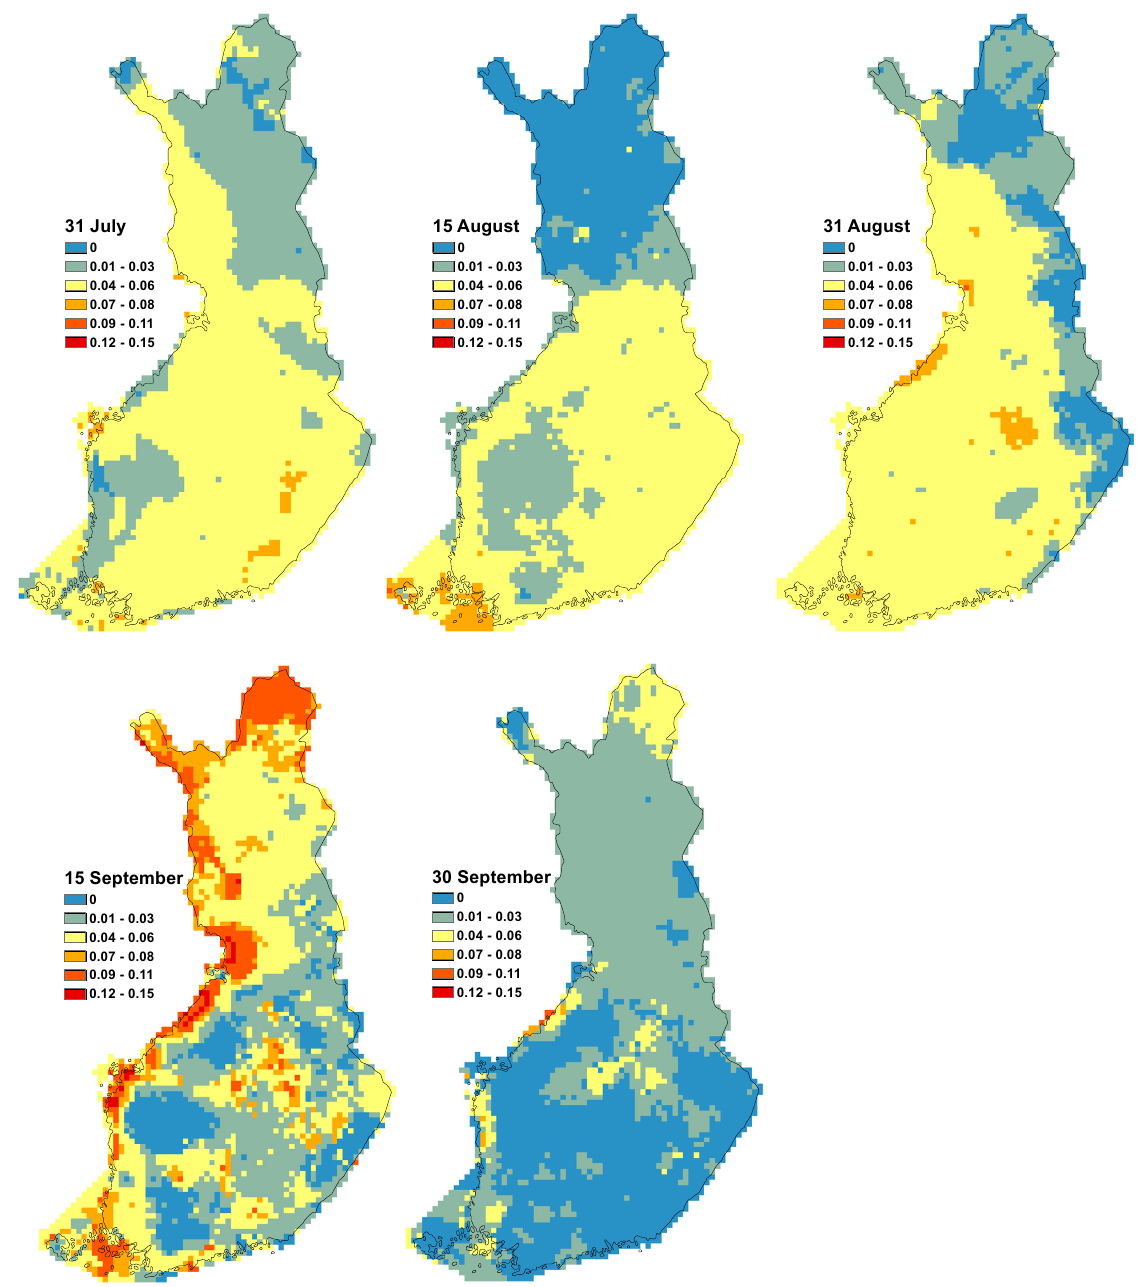
Fig. 3b. Probabilities of elevated temperatures of ≥1 °C that lasted for at least three weeks for the periods that ended on 31